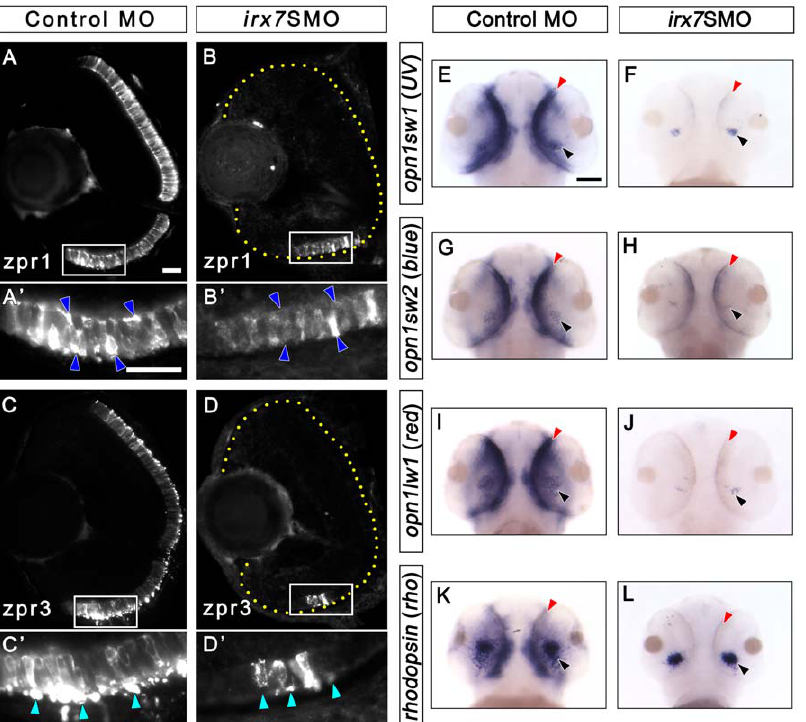
Figure 6. Irx7 knockdown compromises photoreceptor differentiation at 72 hpf. Irx7 knockdown compromised the staining of anti-zpr1 for red-green double cones and anti-zpr3 for rods in the morphants (B and D) compared with the controls at 72 hpf (A and C). (A 9 , B 9 , C 9 and D 9 ) The corresponding magnified view of the positive signal area in the white box in A, B, C and D. The features indicated by the arrowheads are further discussed in the text. Lateral is to the left and dorsal is up for all sections. In addition, the retinal region in the samples with weak fluorescent signal is highlighted by a dotted yellow line. (E–L) Whole-mount in situ hybridization of three cone opsins ( uv , blue and red ) and one rod opsin ( rho ) also indicate the differentiation of these photoreceptors was compromised. The most common staining pattern is shown. The black arrowheads indicate the specific staining (blue colour) of the ventral patch, while the red arrowheads indicate the staining in the ONL. Embryos were imaged from the ventral side and anterior is up. Scale bars=20 m m for (A)–(D) and 50 m m for